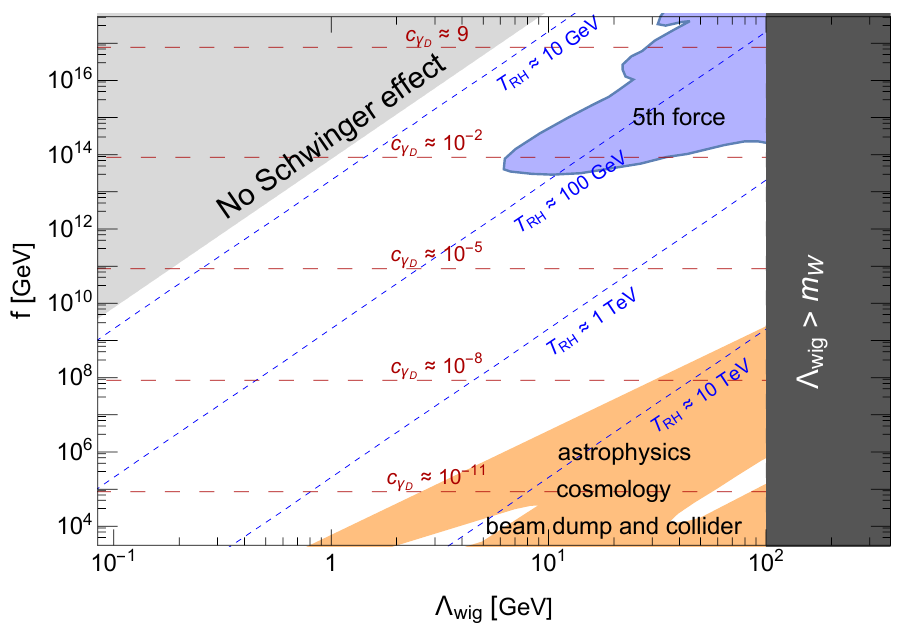
Figure 3 . Summary of constraints on our model. We (cid:12)x f=c (cid:13) in this plot is from 19 to 26. The dashed red contours show the values of c (cid:13) saturate the lower bound in eq. (8.4). The dashed blue contours depict the reheating temperature given in eq. (8.9). The blue region is excluded by 5th force constraints, while the orange region corresponds to a set of constraints from astrophysics, cosmology, beam dump experiments, and colliders; these are explained in detail in [22]. The dark gray area corresponds to values of (cid:3) wig > m W and is excluded as it implies an unacceptable electroweak breaking scale. The light gray region is de(cid:12)ned by the bound eq. (8.8), combined with eq. (8.4). In such a region there is no viable value of the mixing (cid:20) to allow at the same time for reheating via the Schwinger e(cid:11)ect and for the dark photon to avoid a thermal mass. Note that of the dimensionful parameters listed in (8.1), (cid:3), is (cid:12)xed by eq. (4.6), and m does not need to be speci(cid:12)ed as long as eq. (8.3) is satis(cid:12)ed, which is always the